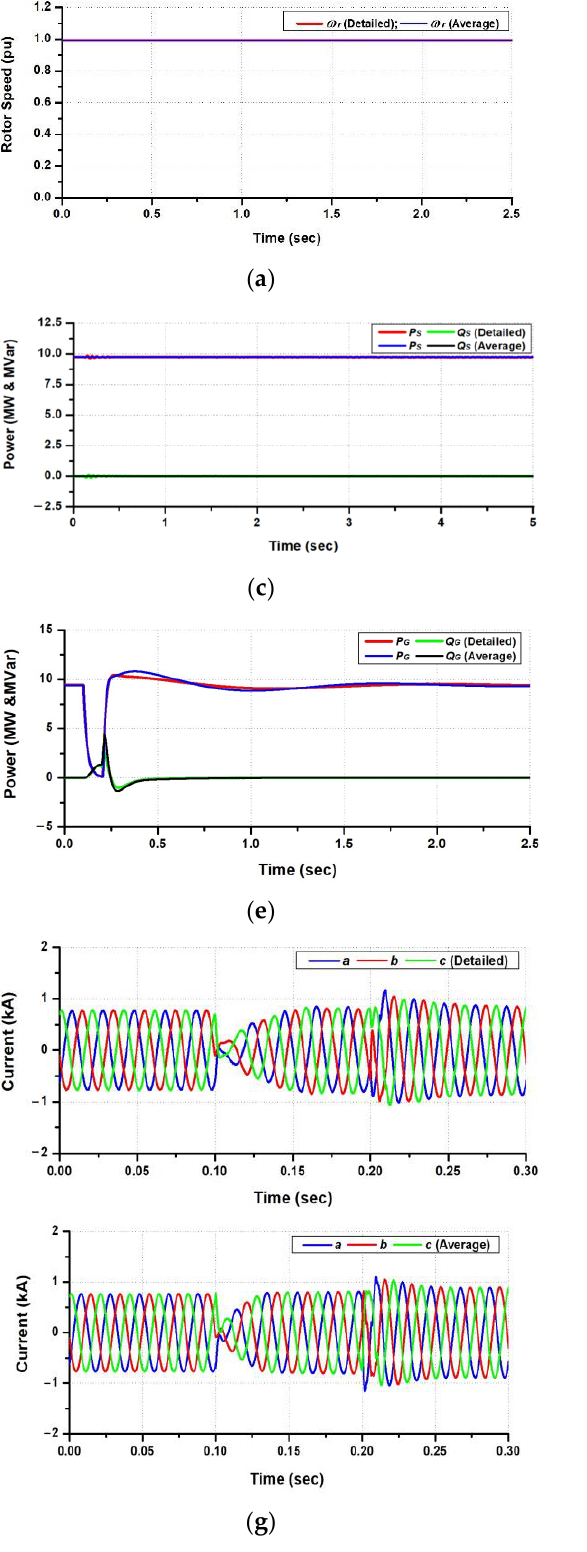
Figure 21. Dynamic performances of WTG1 in the case of 3LG: ( a ) Rotor speed response; ( b ) Voltage profiles at the terminal of the stator winding; ( c ) Active and reactive powers output of the PMSG; ( d ) DC link circuit voltage profile; ( e ) Active and reactive power output of grid-side MMC; ( f ) Voltage profile at Bus BG1; ( g ) Waveform of current at the grid-side MMC; ( h ) Waveform of voltage at the grid-side MMC.